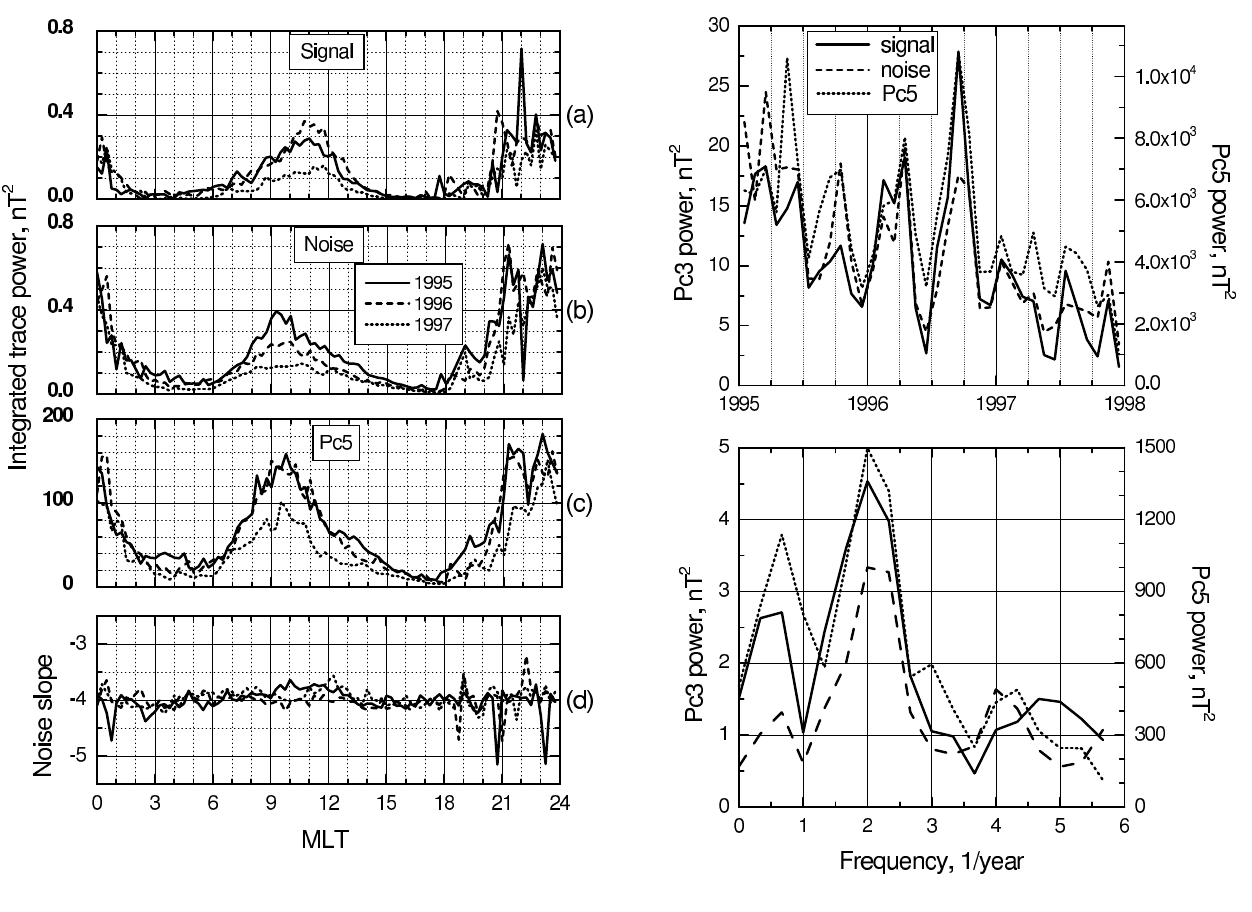
Fig. 6. Diurnal variation in integrated ULF trace power at Davis over 1995–1997, plotted against magnetic local time for (a) Pc3 signal , (b) Pc3 noise , (c) and Pc5 components; and (d) noise slope.